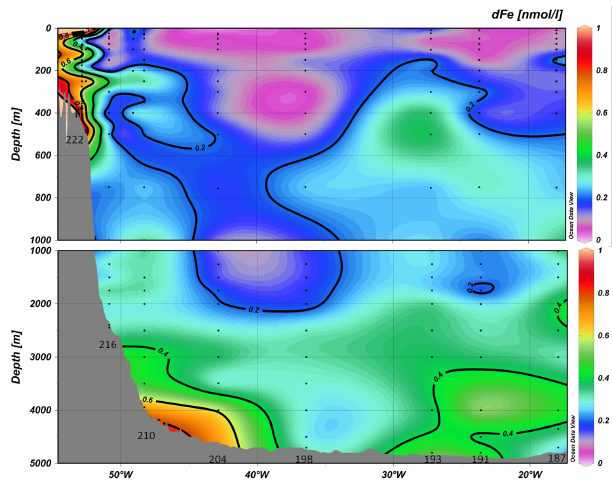
Fig. 3b. Section potential density (Sigma-theta) versus surface ref- erence level (Sigma-0) of the of the Drake Passage transect. Fig. 4a. Section plot of DFe concentrations in the Weddell Sea tran- sect; station numbers 187–216 along horizontal